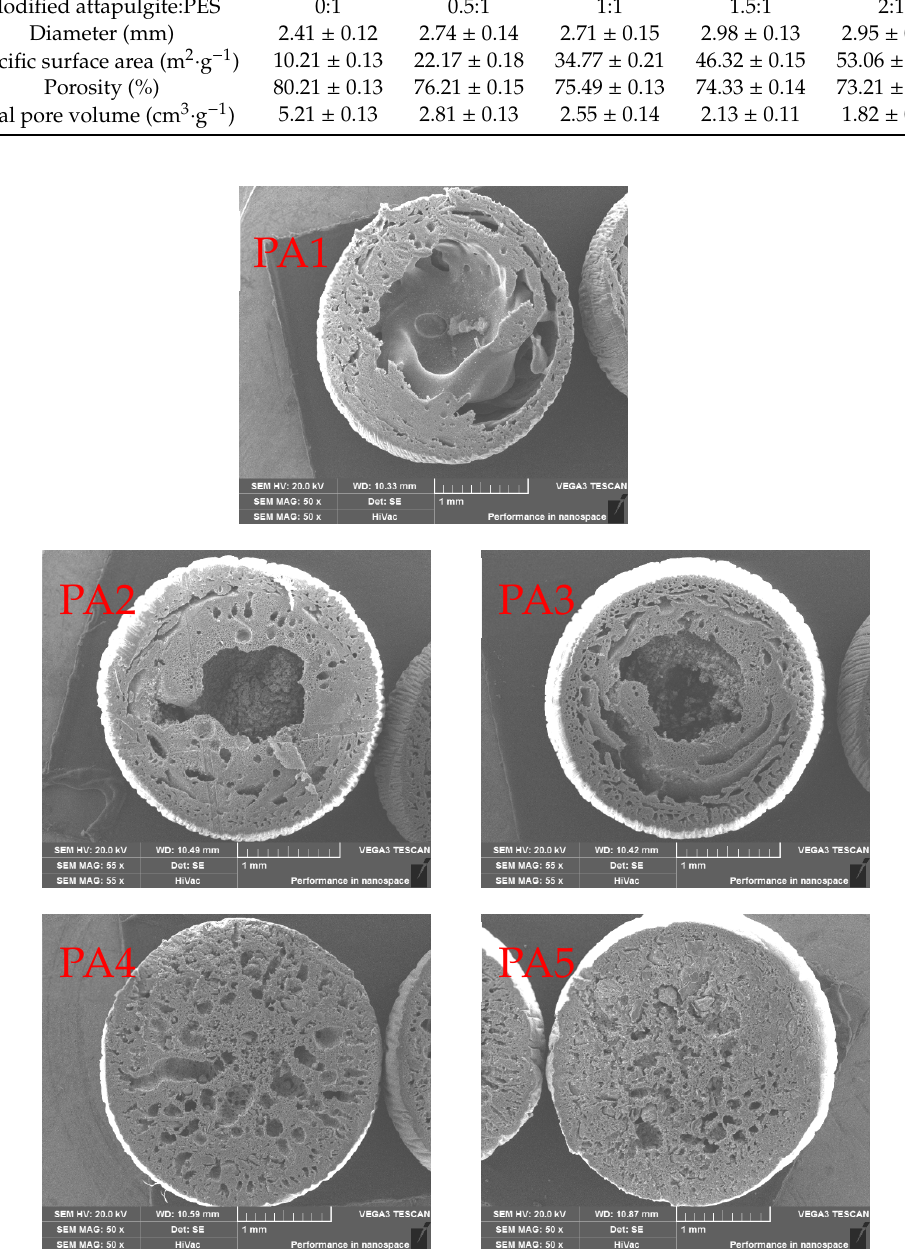
Figure 1. Scanning electron microscopy images of hybrid microsphere. Table 1. Hybrid microsphere diameter, specific surface area, porosity, and total micropore volume.